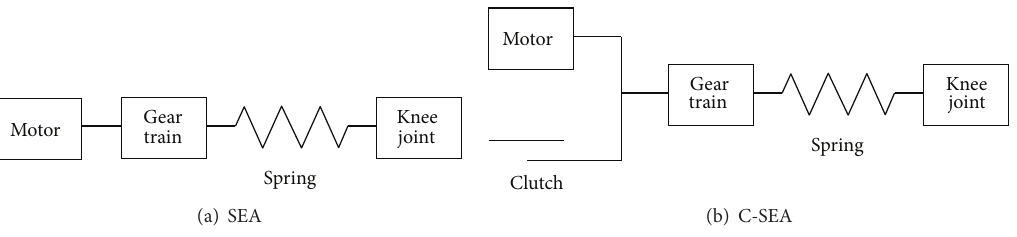
Figure 5: Schematic pictures of the SEA (a) and C-SEA